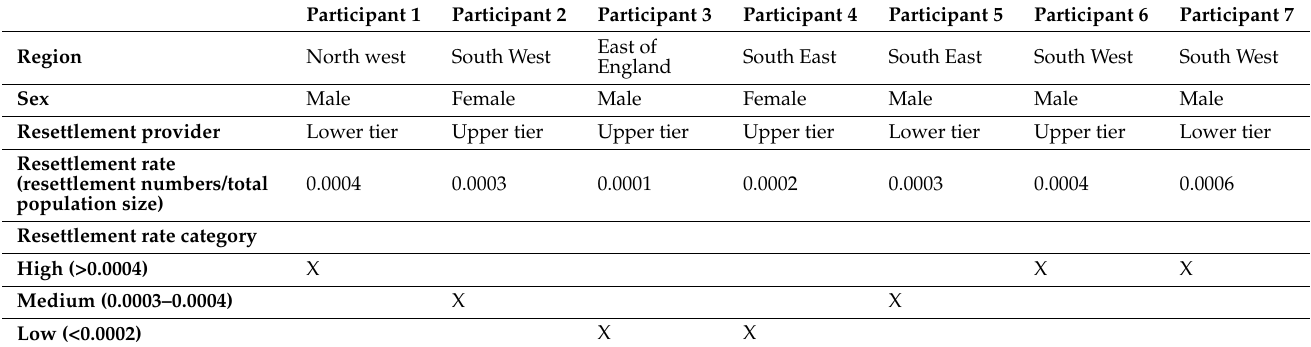
Table 2. Characteristics of the